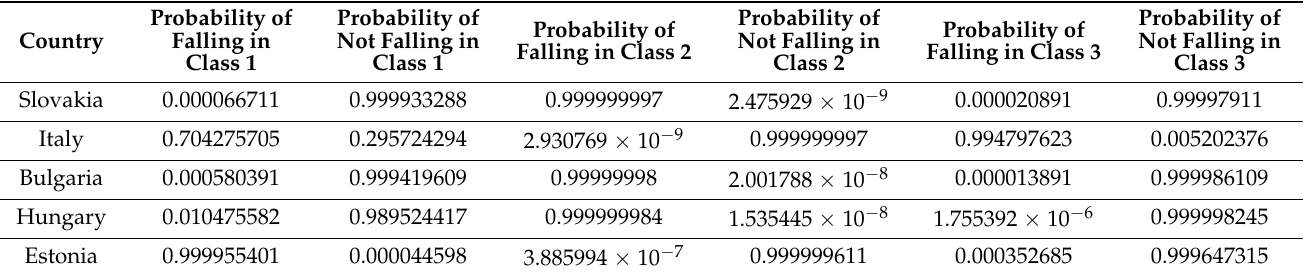
Table 5. Class probabilities for countries included in the testing